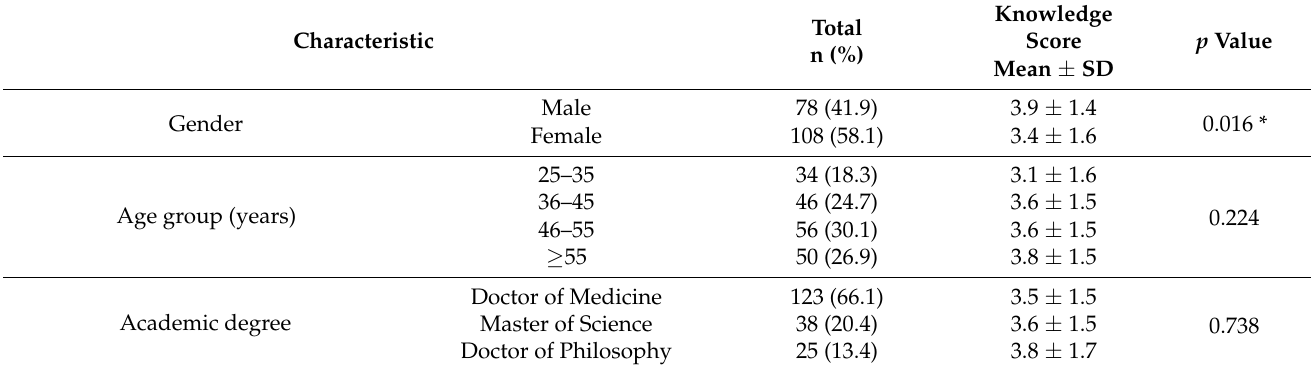
Table 1. Demographic and professional characteristic of respondents (n =